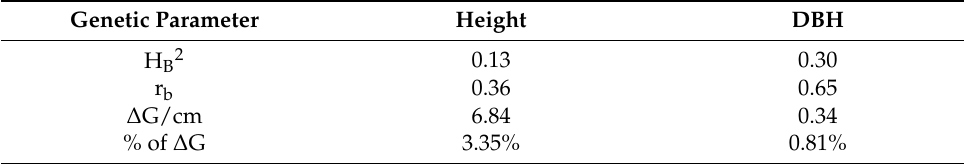
Table 5. Genetic